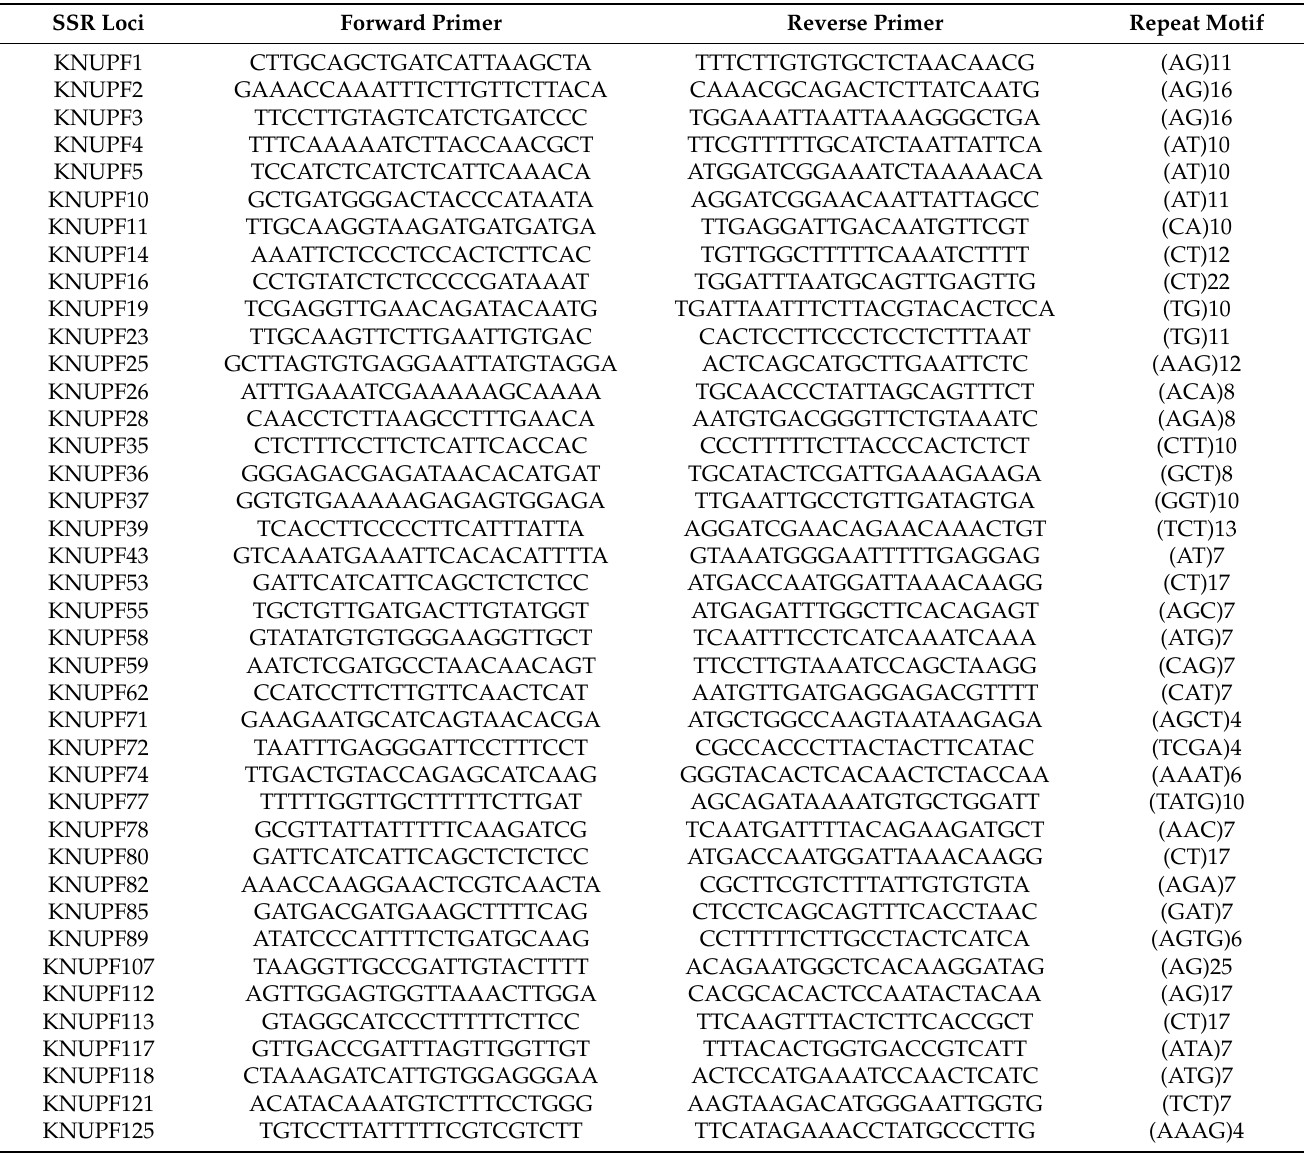
Table 5. Characteristics of the 40 Perilla microsatellite loci used in the study. SSR